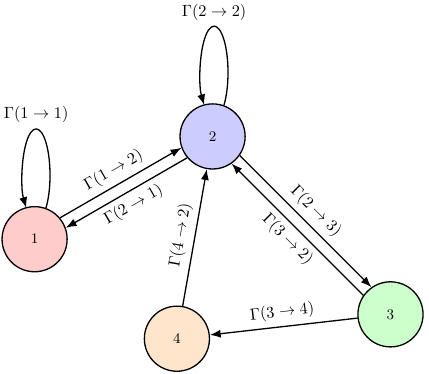
Figure 3: A sample of how a stochastic system can be represented with a network. Nodes correspond to states and directed edges correspond to allowed transitions; the edges are correspondingly weighted by the transition